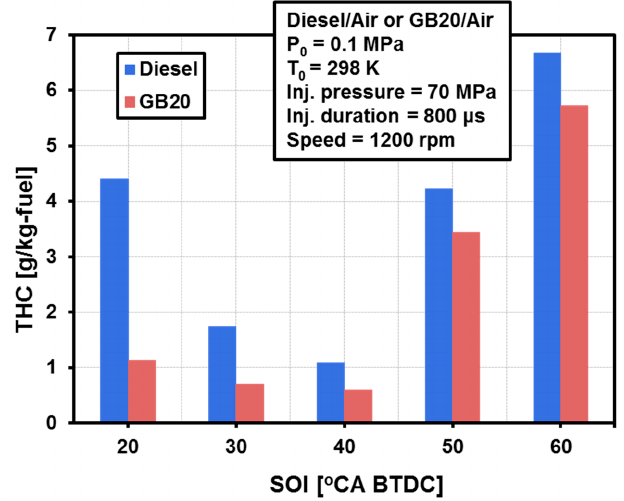
Figure 11. THC emissions [Reprinted from Fuel, Vol. 189, Yanuandri Putrasari, Ocktaeck Lim, A study on combustion and emission of GCI engines fueled with gasoline-biodiesel blends, Copyright (2017); with permission from Elsevier].